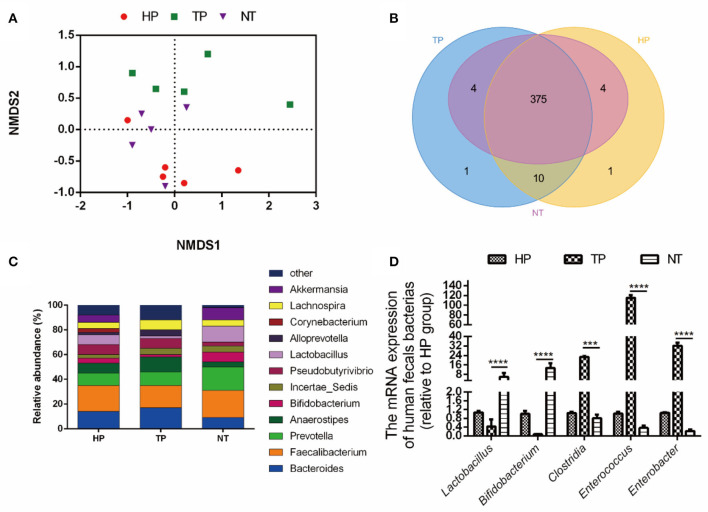
Selection of probiotic strains. (A) The non-metric multidimensional scaling (NMDS) analysis of healthy people (HP) from employees of the Jiangxi Cancer Hospital, tumor patients (TP) from the Jiangxi Cancer Hospital, and non-cancer people (NT) (healthy residents at the cancer-free village). (B) The Venn diagram of the intestinal microbiota among HP, TP, and NT. (C) The relative abundance of the bacteria among groups HP, TP, and NT. (D) The relative abundance of bacteria among the HP, TP, and NT groups with quantitative real-time PCR (qRT-PCR). The data are presented as means ± SD, where ***p < 0.001 and **** p < 0.0001.